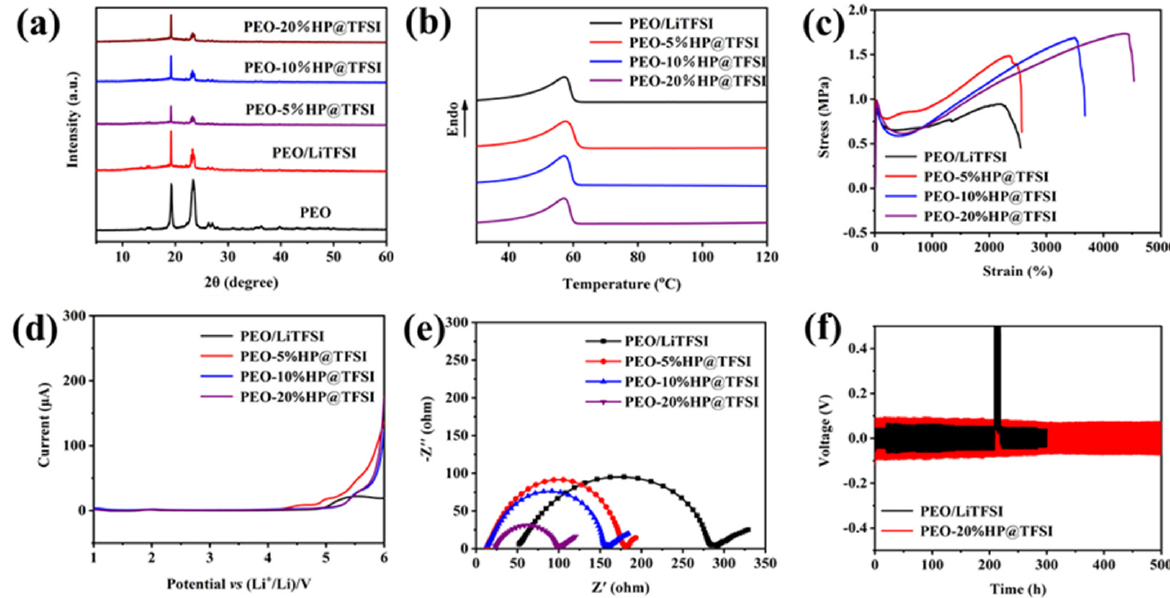
Figure 4. ( a ) XRD patterns of PEO and PEO-HP@TFSI polymer electrolytes; ( b ) DSC traces of PEO and PEO-HP@TFSI polymer electrolyte; ( c ) Tensile stress-strain curve of polymer electrolytes; ( d ) LSV curves of polymer electrolytes at 60 °C; ( e ) Interface EIS spectrum of polymer electrolytes; ( f ) Li plating and stripping test at a current density of 0.1 mA·cm − 2 at 60 °C.